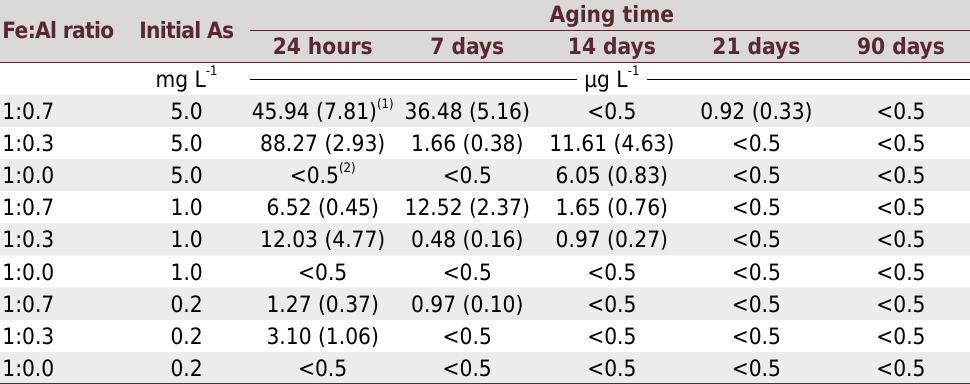
(1) Numbers between brackets are the two-sigma standard deviation of replicates. (2) The number after the symbol < means the detection limit of the analytical